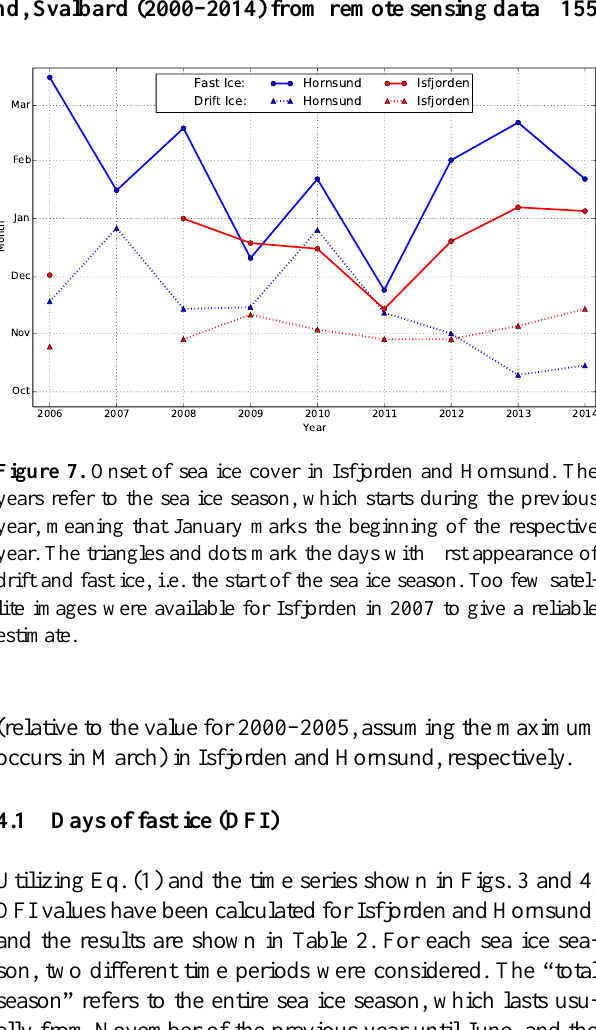
Figure 6. Monthly averaged fast ice coverage in Hornsund shown for three time periods: 2000–2014 (mean in black and standard de- viation in grey) 2000–2005 (blue) and 2006–2014 (red).